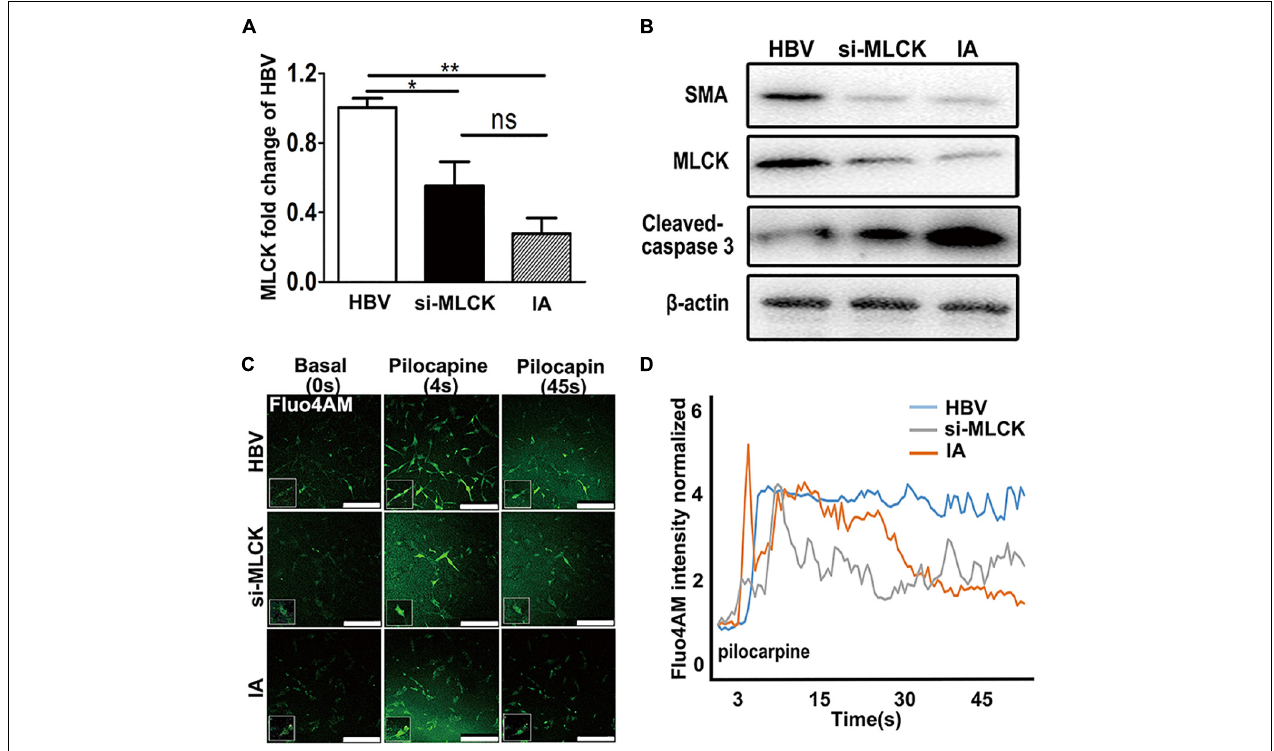
FIGURE 3 | Both si- mlck HBVSMCs and IASMCs show weak proliferation and contraction. (A,B) MLCK expression in HBVSMCs, si- mlck HBVSMCs and primary IASMCs was detected at the mRNA and protein levels. (C) Ca 2 + flux measured by Fluo-4 AM loading and the intensity in HBVSMCs, si- mlck HBVSMCs, and IASMCs at a basal level (0 s), upon stimulation with pilocarpine (4 s) and at 45 s after stimulation. (D) Quantification of contractility measured as the fluorescence change in the cell surface area of HBVSMCs, si- mlck HBVSMCs, and IASMCs. The relative mRNA level was normalized to GAPDH. Data are presented as the means ± SD, ∗ p < 0.05, ∗∗ p < 0.01. HBVSMC, human brain vascular smooth muscle cell; IASMC, intracranial aneurysm smooth muscle cell; si- mlck SMC, HBVSMCs with interfered